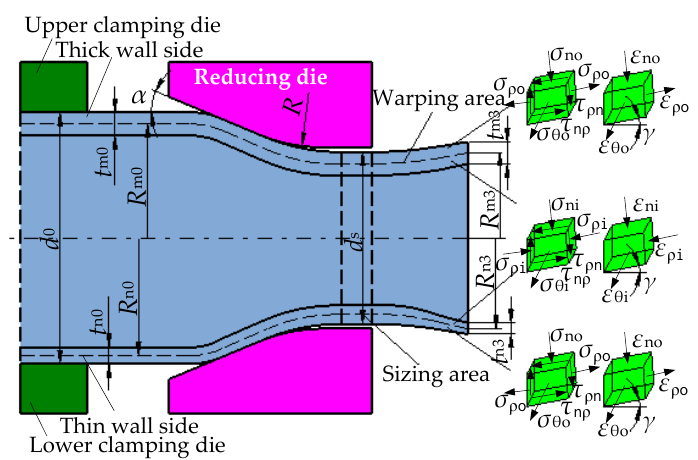
Figure 9. Warping stage.